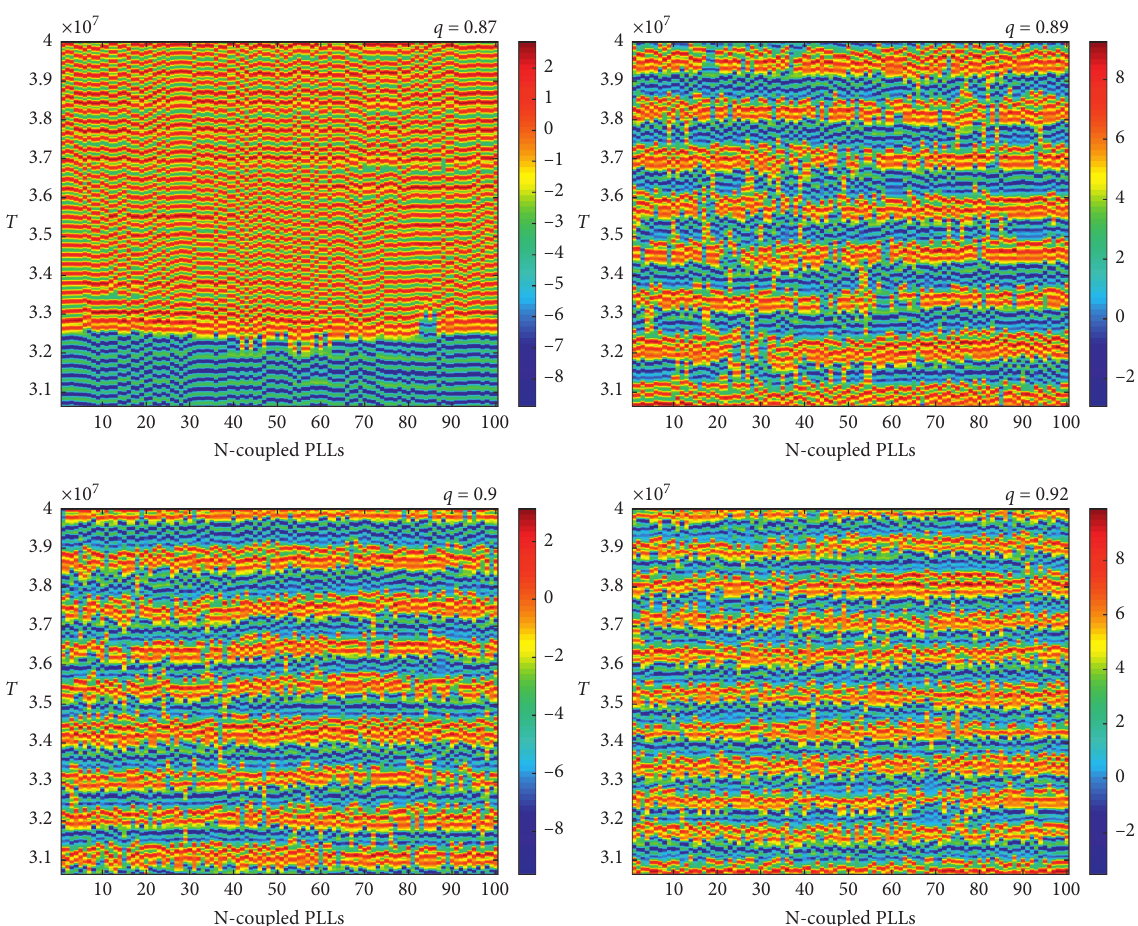
Figure 9: Spatiotemporal behaviour of the FOPLL network for different fractional orders. We have used random initial conditions with coupling strength D � 1 and parameters K � 2.6 and G �